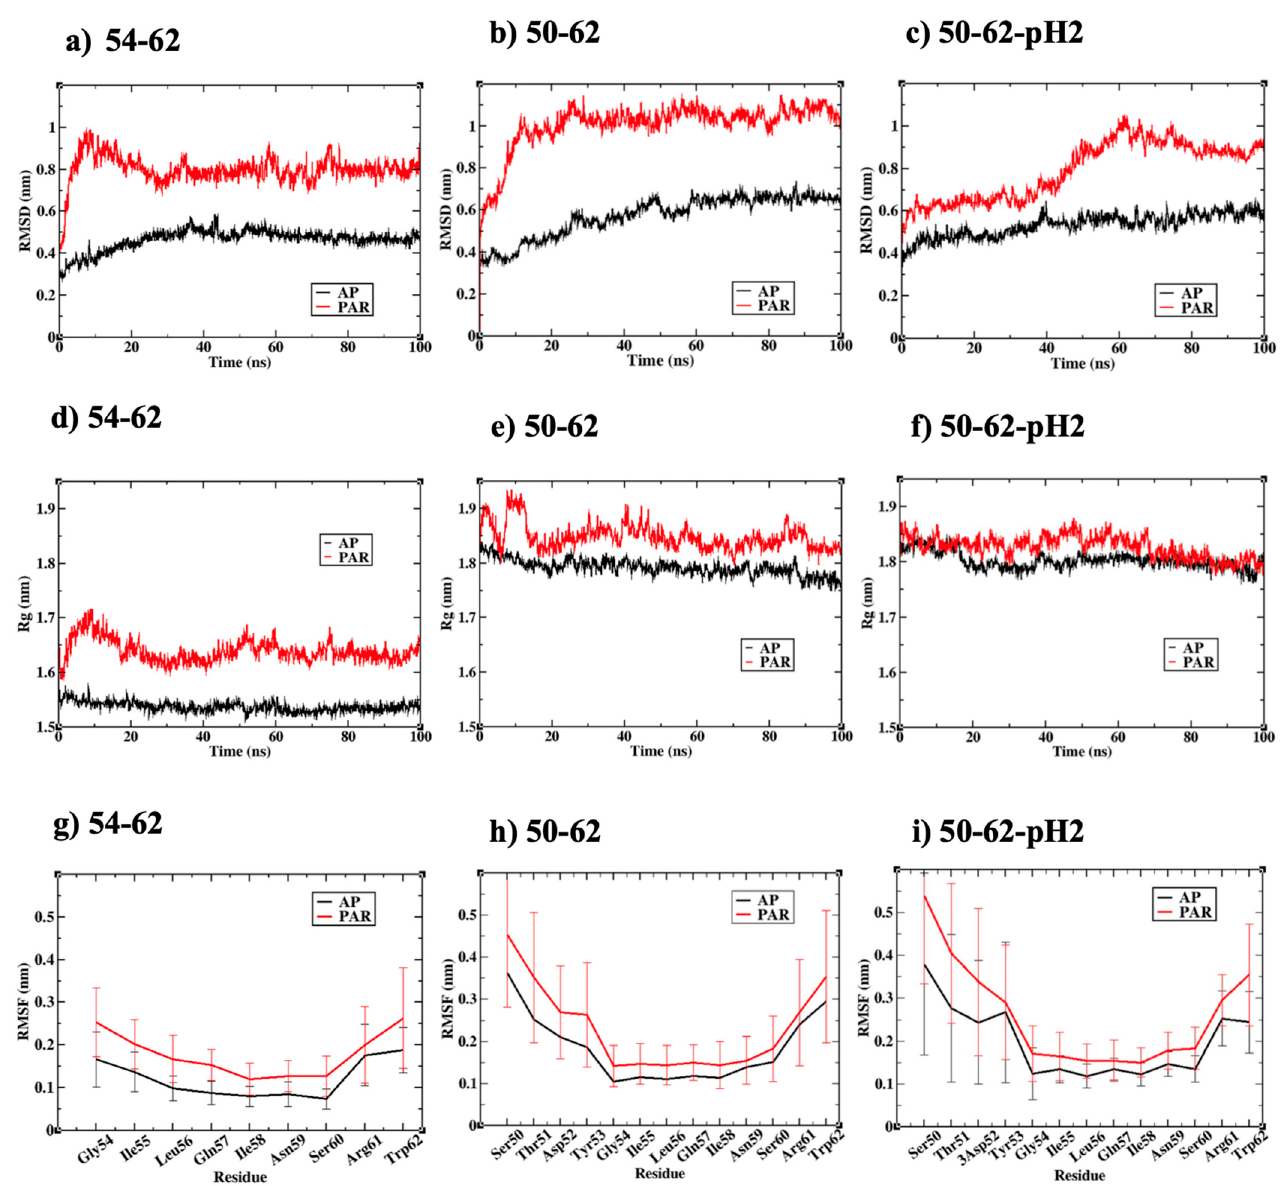
Figure 2. ( a – c ) root mean square deviation (RMSD) of all simulated systems along 100 ns trajectories, ( d – f ) radius of gyration (Rg) of all simulated systems along 100 ns trajectories, ( g – i ) root mean square fluctuation (RMSF) of all simulated systems calculated from the last 50 ns. Data presented in black annotated the antiparallel models and data presented in red annotated the parallel models.